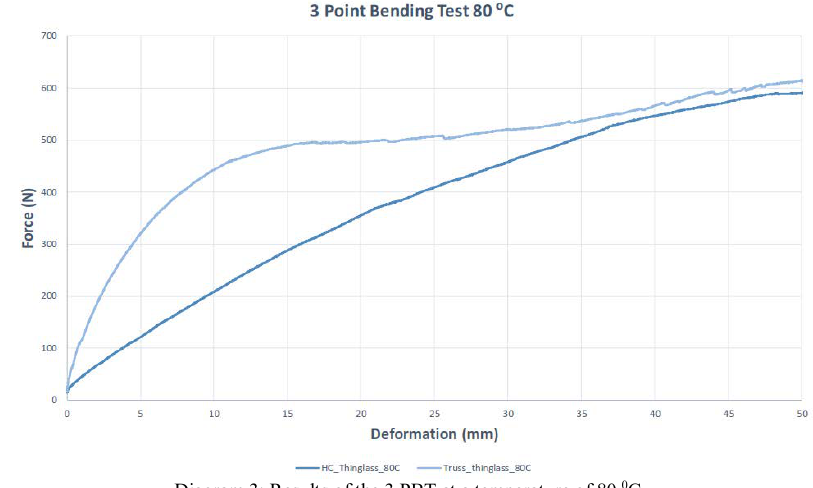
Diagram 3: Results of the 3 PBT at a temperature of 80 0